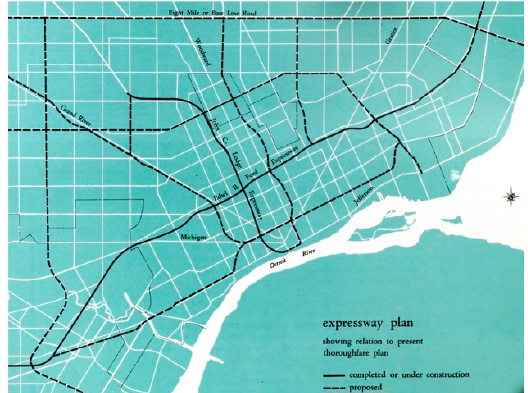
Figure 2. Expressway Plan, Trafficways for 3 Million People. Courtesy Detroit Department of Planning and Development.